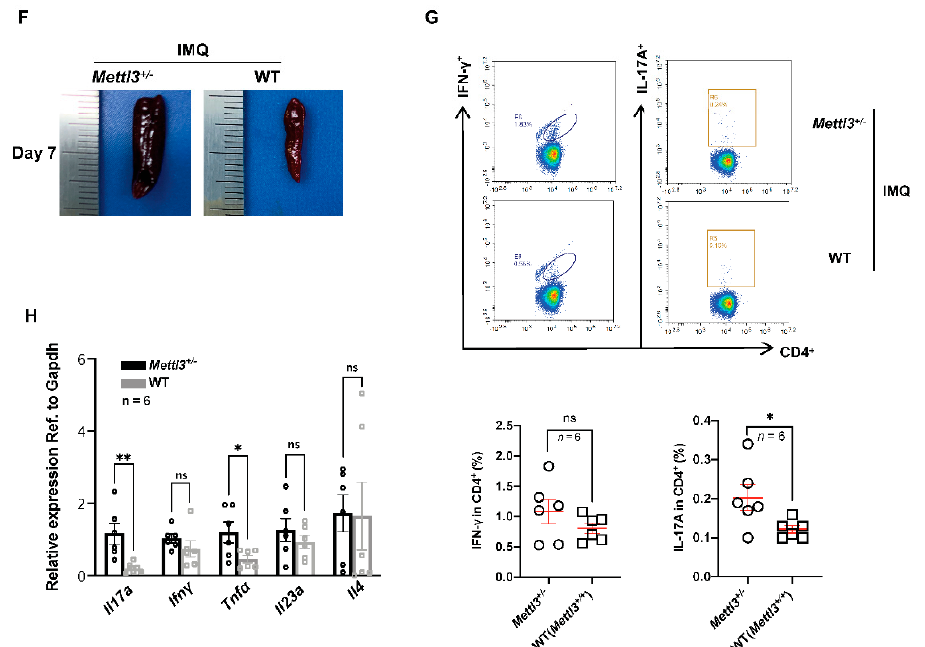
Figure 2. Heterozygous knockout of Mettl3 accelerated the development of psoriasis. ( A ) Schematic diagram of the experimental plan on IMQ − treated mice (C57BL/6J). Six mice in each group were sacrificed on days 4, 7, and 10 to conduct experiments. ( B ) Phenotypic presentation and H&E staining of lesional skin from Mettl3 +/ − and WT ( Mettl3 +/+ ) mice. Scale bars: 100 µ m. ( C ) PASI scores of mice in Mettl3 +/ − and WT ( Mettl3 +/+ ) groups ( n = 6). ( D ) Acanthosis and dermal cellular infiltrates were quantified for Mettl3 +/ − mice ( n = 6) or WT ( Mettl3 +/+ ) mice ( n = 6). For all measurements in D, the median number of specifically stained dermal nucleated cells was counted in six areas in three sections of each sample. ( E ) Expression of Mettl3 in skin samples from Mettl3 +/ − mice ( n = 6) and WT ( Mettl3 +/+ ) mice ( n = 6). ( F ) The size of spleens of mice in the Mettl3 +/ − and WT ( Mettl3 +/+ ) groups. ( G ) Representative flow cytometric analysis of Th1 and Th17 cells in splenic CD4+ T cells from Mettl3 +/ − ( n = 6) or WT ( Mettl3 +/+ ) ( n = 6) mice treated with IMQ for 7 days. ( H ) The mRNA levels of Il17a, Ifn γ , Tnf α , Il23a , and Il4 in skin samples from Mettl3 +/ − ( n = 6) or WT ( Mettl3 +/+ ) mice ( n = 6). Data (C − H) were obtained on the seventh day. Data represent the mean ± SEM. * p < 0.05, ** p < 0.01. NS, not significant. Circle, point, triangle and square represent each sample. Two-tailed unpaired Student’s t test ( C − E , G , H ) was